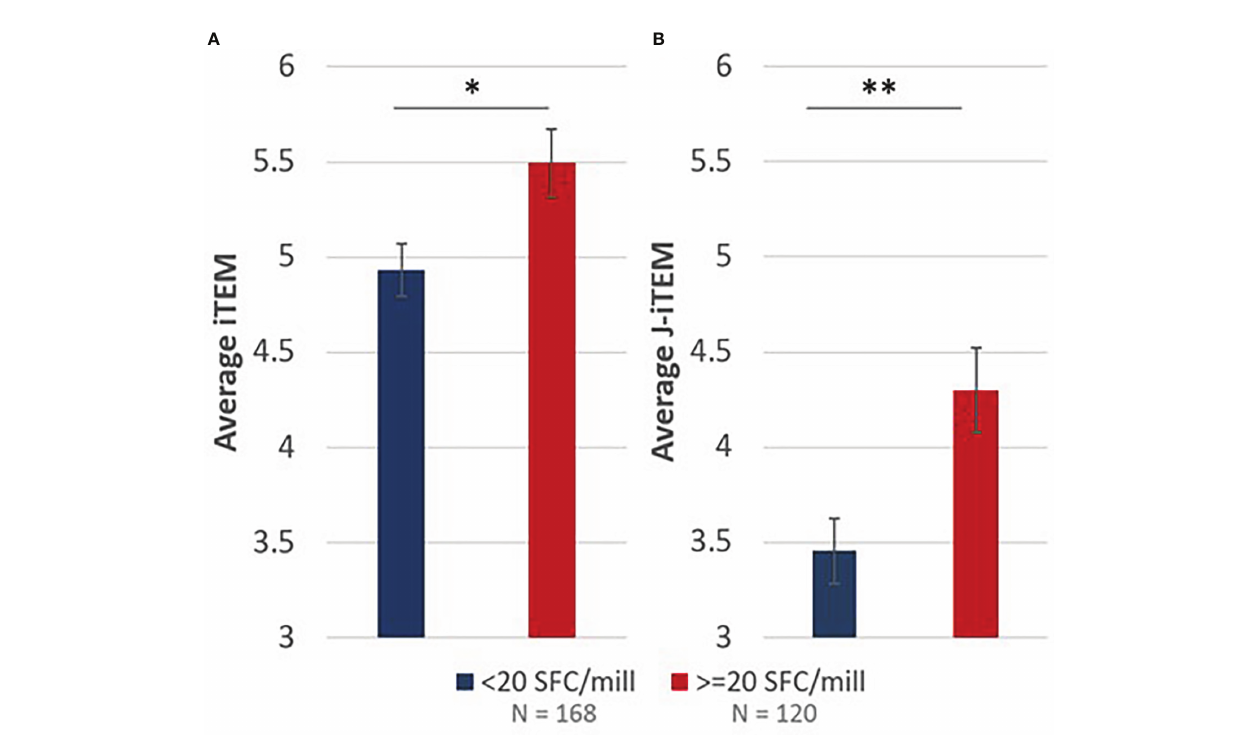
FIGURE 7 | iTEM (A) and J-iTEM (B) calculations demonstrate a statistically signi fi cant positive correlation between in silico EpiMatrix and JanusMatrix predictions and ex vivo IFN- g recall responses. Error bars represent standard error. * indicates p < 0.05 and ** indicates p <